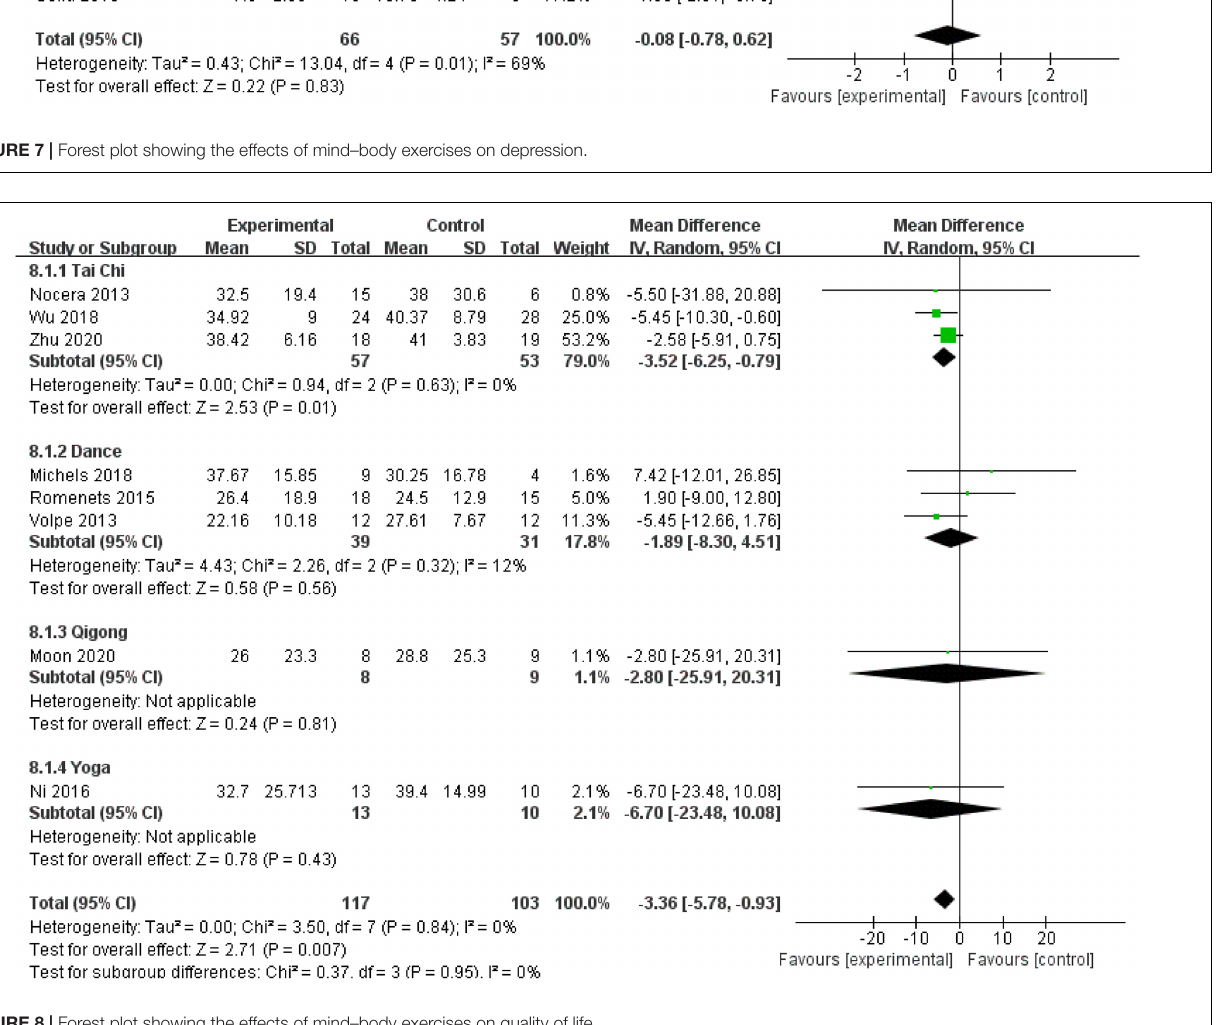
reduced ( P = 0.57, I 2 = 0%), but the overall effect did not